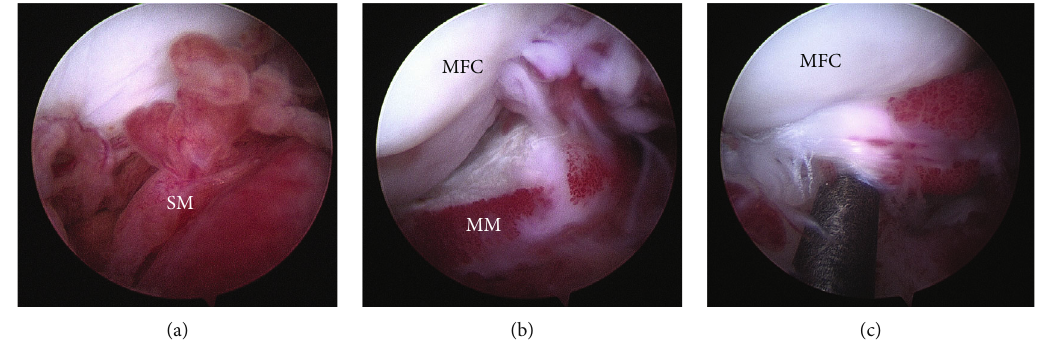
Figure 3: Arthroscopic images from a 6-year-old male intact German Shepherd Dog with severe osteoarthritis and synovial e ff usion in which arthroscopy was used as management for CR. Synovitis was graded based on previously published guidelines [15]. These images represent severe hypertrophy, vascularity, and synovitis. (a) In fl amed synovial membrane with enlarged synovial villae, (b) arthroscopic view of the medial aspect of the intercondylar notch, and (c) medial femoro-tibial joint with a chronic meniscal tear. Note: SM: synovial membrane; MFC: medial femoral condyle; MM: medial meniscus. Table 3: Arthroscopic grading of synovial pathology and cruciate ligament fi ber rupture in dogs with chronic cruciate ligament rupture. Patient